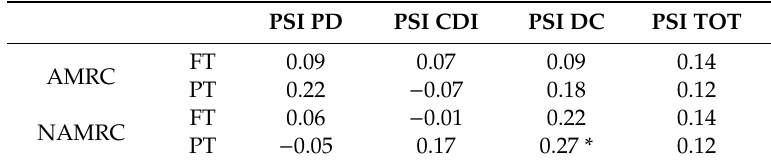
Table 4. Spearman’s intercorrelations between mind-mindedness and the parenting stress of the PT and FT mothers participating in the study. PSI PD PSI CDI PSI DC PSI TOT FT 0.09 0.07 0.09 0.14 AMRC PT 0.22 − 0.07 0.18 0.12 FT 0.06 − 0.01 NAMRC